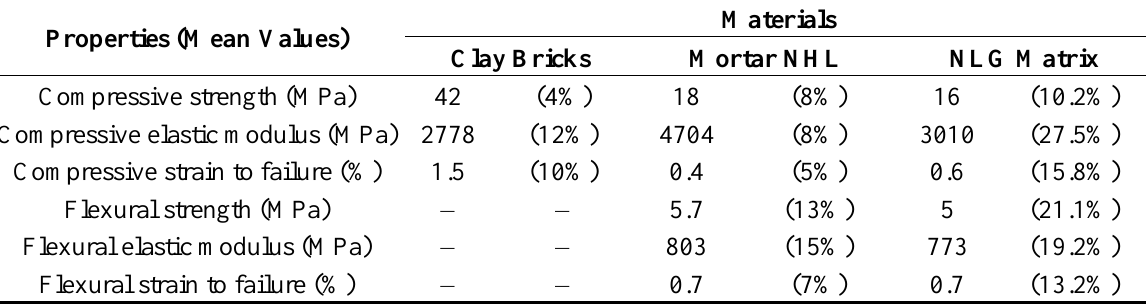
Figure 1. ( a ) Compression test on clay bricks; ( b ) Compression test on mortar specimens; ( c ) Three-point bending tests on prismatic mortar samples. Table 1. Mechanical properties of the bricks and